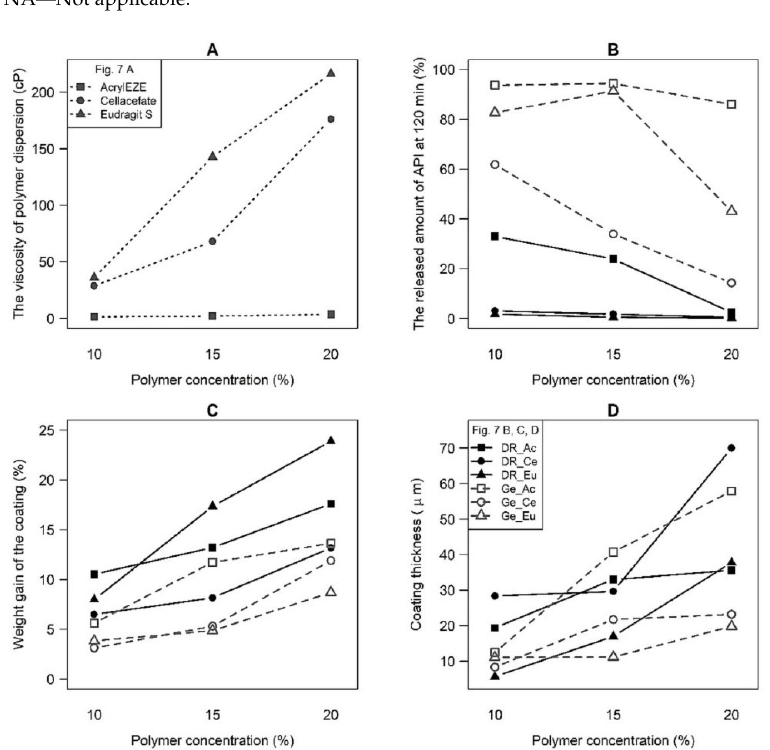
Figure 7. Interaction plot for ( A ) the viscosity of polymer dispersion, ( B ) the released amount of API at 120 min, ( C ) weight gain of the coating and ( D ) coating thickness; polymer types differentiated by symbols; DRcaps TM samples (black, solid line) vs. hard gelatin capsules (grey, dashed line).